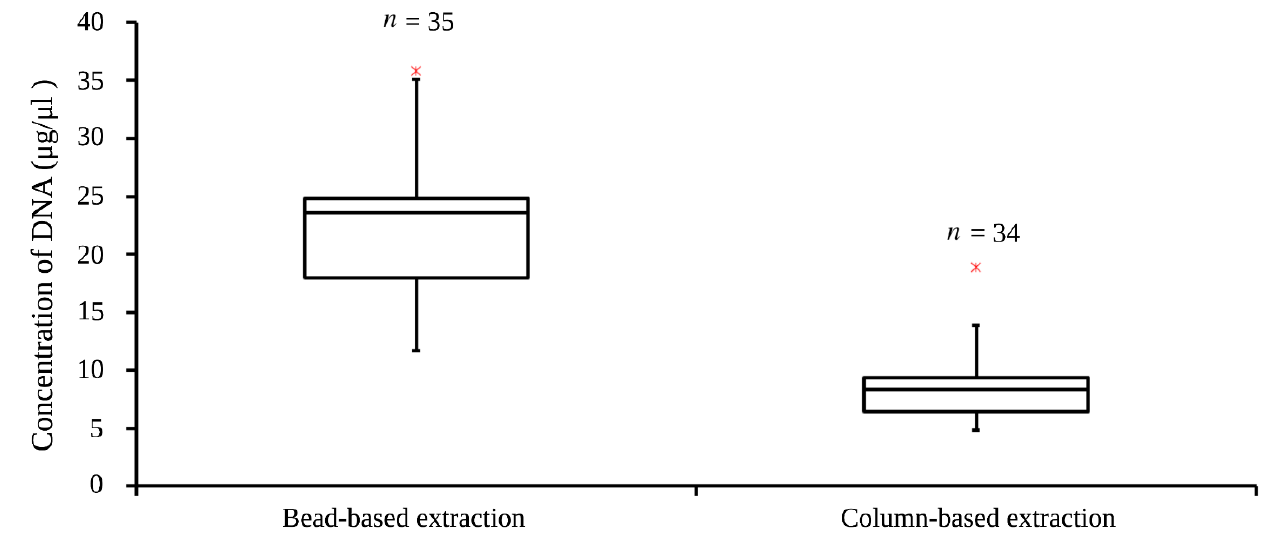
Figure 8. The boxplot of concentration of DNA showed the median (line), Q1 and Q3 percentiles (box), 1.5 interquartile range (whiskers) and outliers (red asterisks). The Q1 of bead-based extraction was 18.0 µ g/ µ L and Q3 was 24.8 µ g/ µ L. The Q1 of column-based extraction was 6.4 µ g/ µ L and Q3 was 9.4 µ g/ µ L.